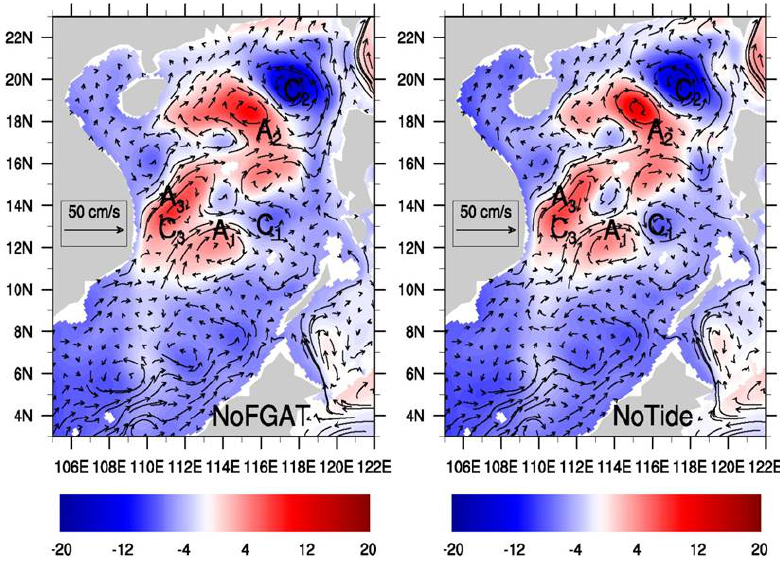
Fig. 15. Comparison of the monthly surface currents (black arrows) and SLA (shaded colors) in May 1995 for the two additional assimilation runs (NoFGAT, left; NoTide, right). The marker A 1 , A 2 , A 3 , and C 1 , C 2 , C 3 denote the positions of anticyclonic and cyclonic eddies according to Chu et al. (1998).